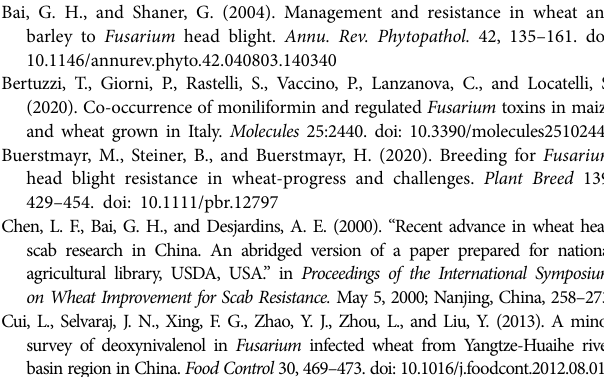
( Figure 5 ) in both breeding procedure and national trials to avoid losing some of the low DON accumulation